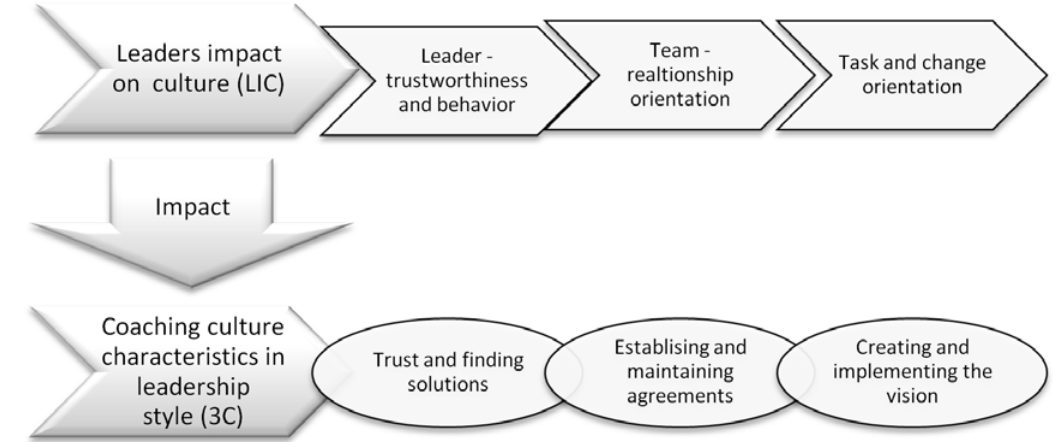
Fig. 3. The interrelations between the 3C and LIC